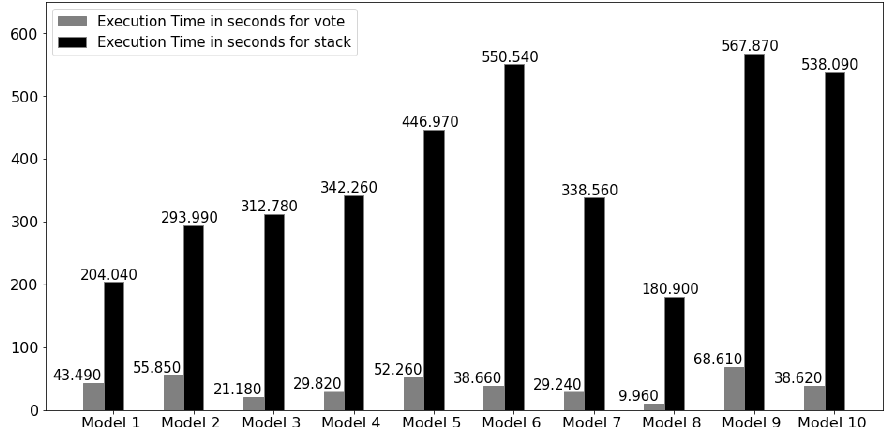
Figure 5. Execution times of all models.